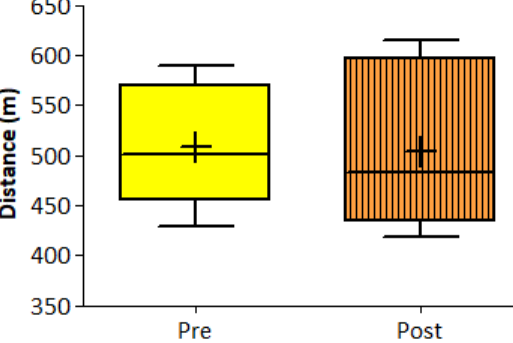
Figure 6. The 6 min walk test. Box plots of pre- and post-intervention distances covered during the 6MWT by the entire